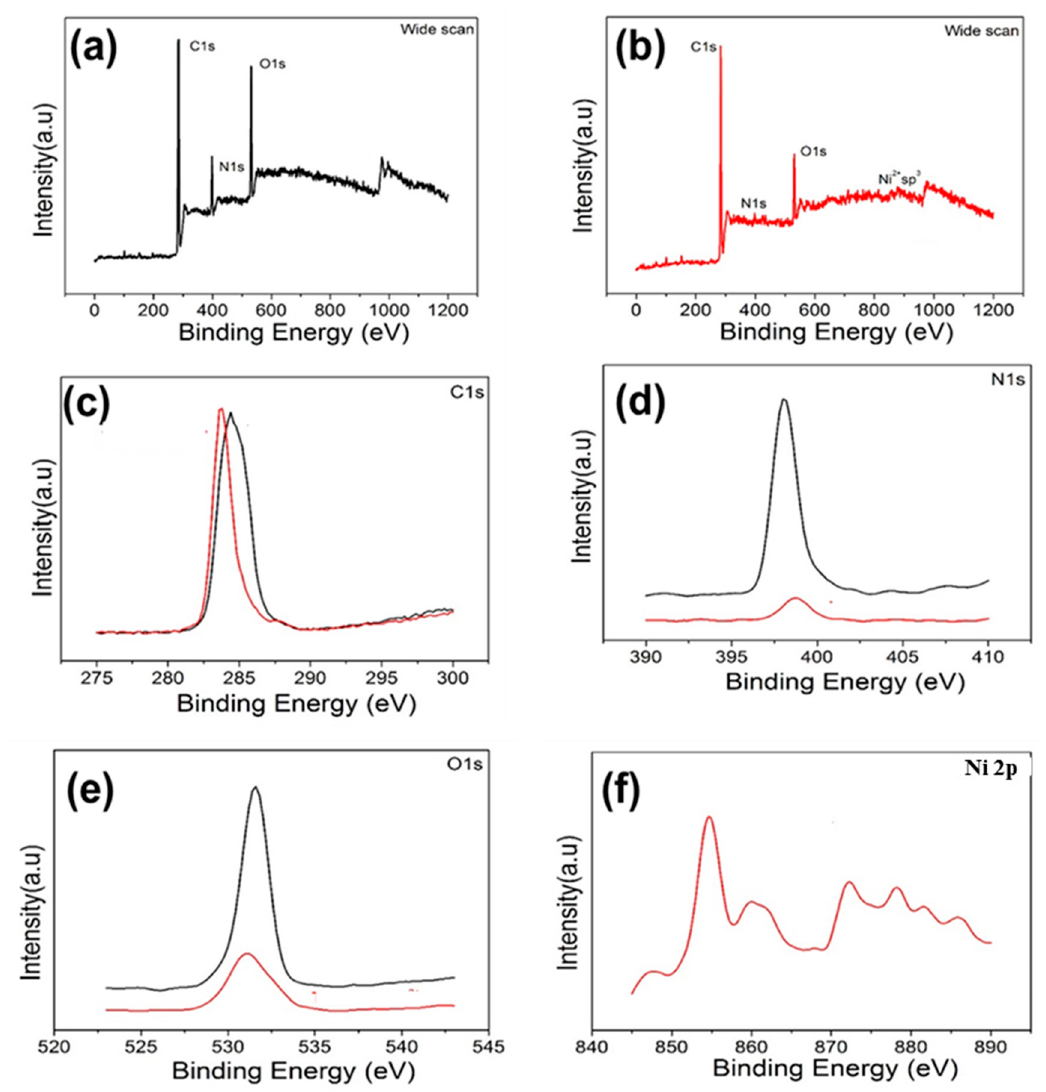
Figure 4. Wide-scan XPS spectra of ( a ) gauze@PEI 0.4 /PEGDE 1 /TETA 0.6 and ( b ) Ni 2+ adsorbed gauze@PEI 0.4 /PEGDE 1 /TETA 0.6 . XPS spectra of ( c ) C 1s; ( d ) N 1s; ( e ) O 1s, and ( f ) Ni 2p regions in gauze@PEI 0.4 /PEGDE 1 /TETA 0.6 (black line) and gauze@PEI 0.4 /PEGDE 1 /TETA 0.6 after Ni 2+ adsorption (red line).